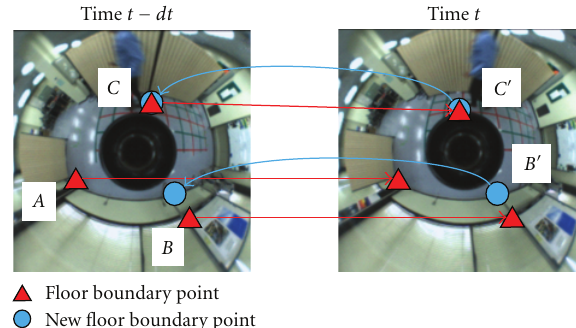
Figure 4: The example of classification process by using floor boundary points. Triangles are tracked from the left image to the right image. Circles are tracked from the right image to the left image. The robot moves by 20 cm.